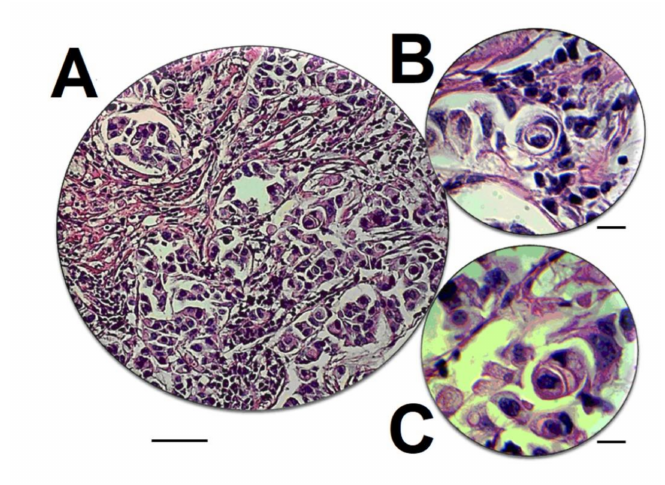
Figure 4. Entosis detected in metastases of double-negative ductal breast carcinoma into axillar lymph node. ( A ) Subcapsular region of axillar lymph node; original magnification 200 × . ( B , C ) Selected entotic figures form picture ( A ); original optical magnification 200 × and digital magnification 2.5 × . Scale bars: